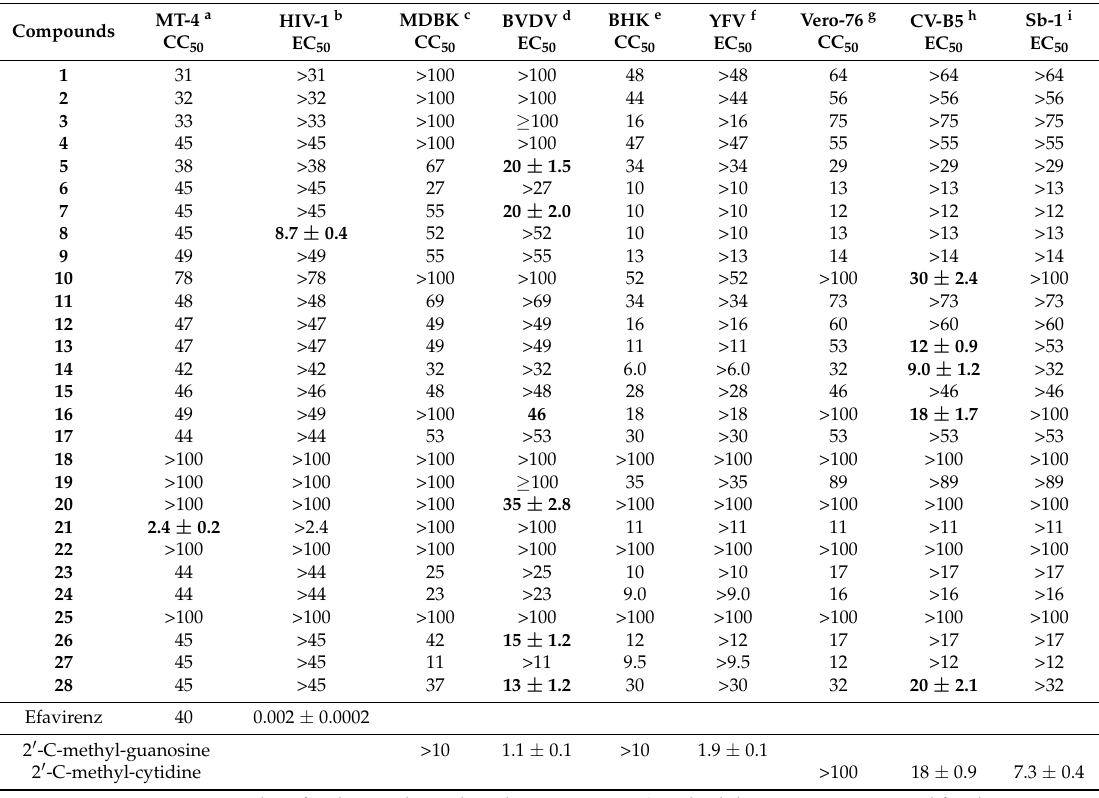
Table 5. Antiviral activity of thiourea derivatives against HIV-1 and ssRNA+ (BVDV, YFV, CV-B5, Sb-1) viruses and cytotoxicity against the cell lines used in the assays.